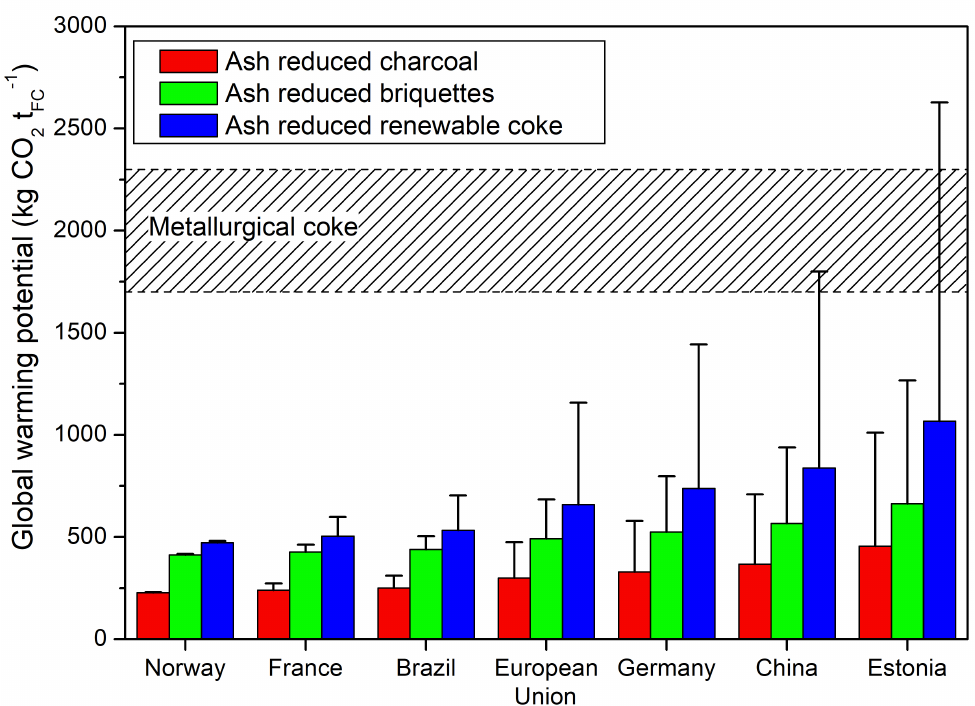
Figure 7. Global warming potential of ash reduced charcoal, briquettes and renewable coke based on countries with different power supply including references values for the global warming potential of metallurgical coke production and usage in iron and steel industries